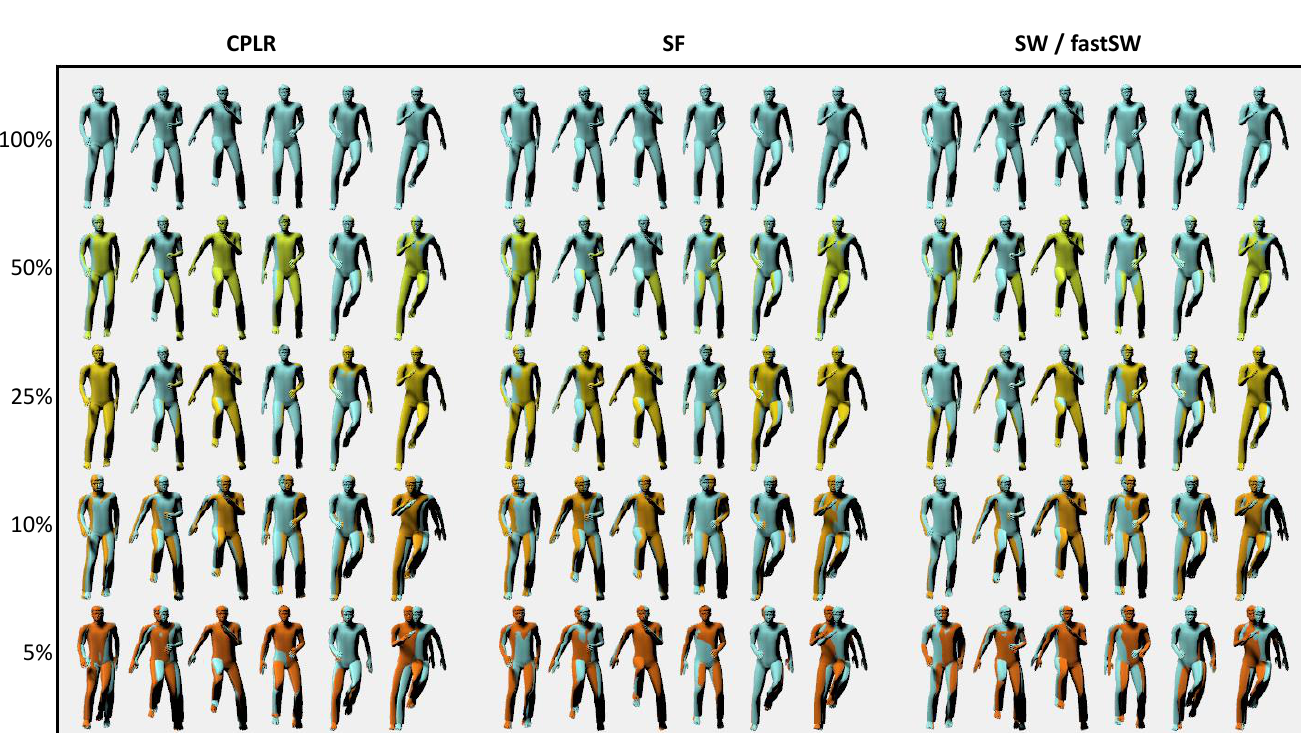
Figure 5. Reconstruction results of the fast-paced running on spot activity of user MR from the TNT15 dataset. Left: CPLR, Middle: SF, Right: SW/fastSW. Single frames (from left to right) are taken at six different time points every 100 ms. Colors indicate file size w.r.t. the original size and are arranged from top to bottom, with: The original file (light blue), 50% (light green), 25% (yellow), 10% (orange), and 5% (dark orange) of the original file size. Ground truth frames (light blue) are overlaid over all frames to highlight deviations. At 50% and 25%, a good approximation is obtained from all methods. Higher compression ratios yield less accurate